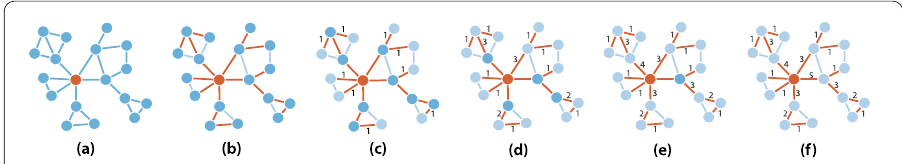
Figure 1 Calculation of transmissioncentrality of links. ( a ) A network with a randomly selected seed node; ( b ) the branching tree rooted from the initial seed (root and edges in the tree are colored in red); ( c ) for each leaf edge in the branching tree increase the counter by 1; ( d )–( f ) remove leafs and increase the counter of their ascendant by the counter of the removed